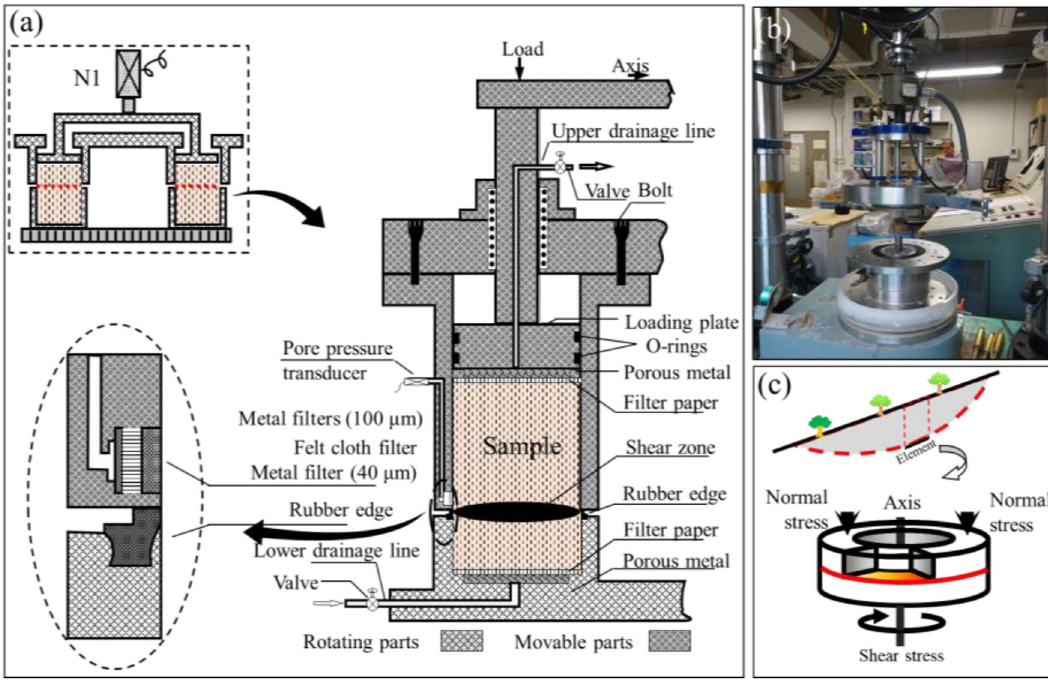
Figure 6. Configuration of DPRI 5 ring shear apparatus ( a ) The design of undrained ring shear box a The conception of ring shear test; ( b ) Ring shear test equipment; ( c ) The conception of ring shear test (Modified from Cui et al. 20